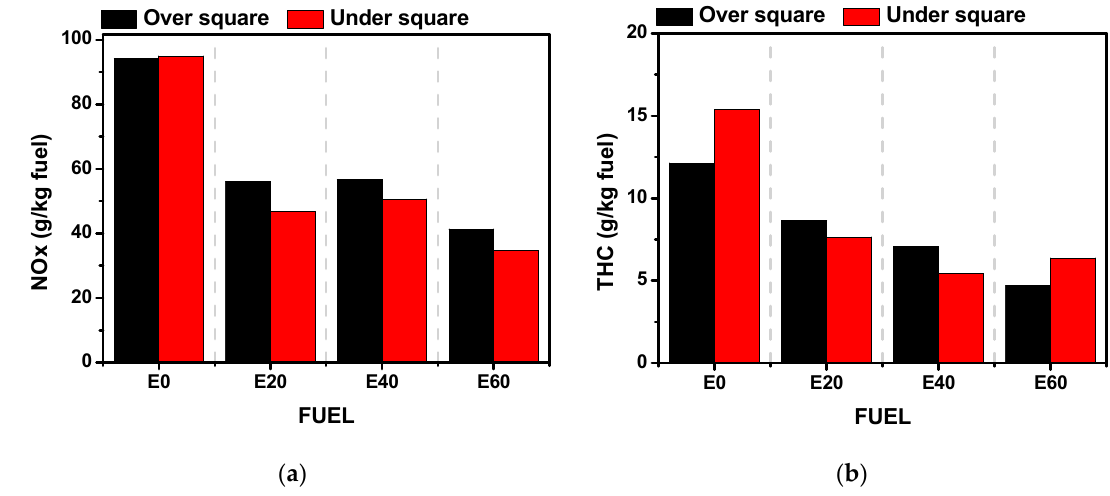
Figure 12. ( a ) NOx and ( b ) THC emissions for over- and under-square engine vs. ethanol blending ratio.